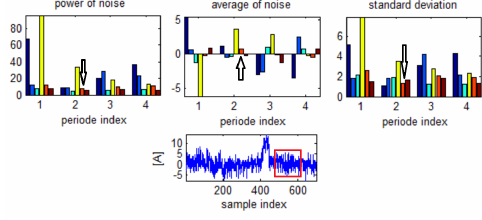
Figure 3. Estimated noise signals for an analyzed dataset, for all 4 periods (ordered top-down, left-right, 1-st period, 2-nd period a.s.o.)..